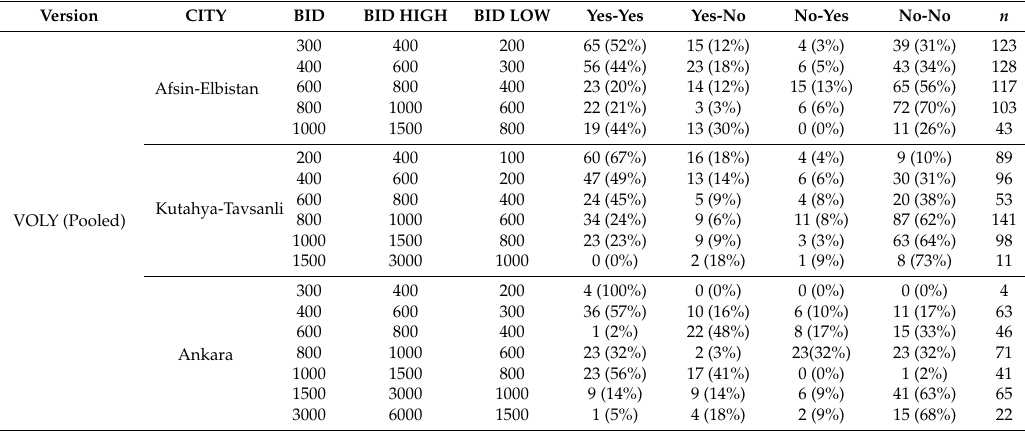
Table 2. Bid Structure and response